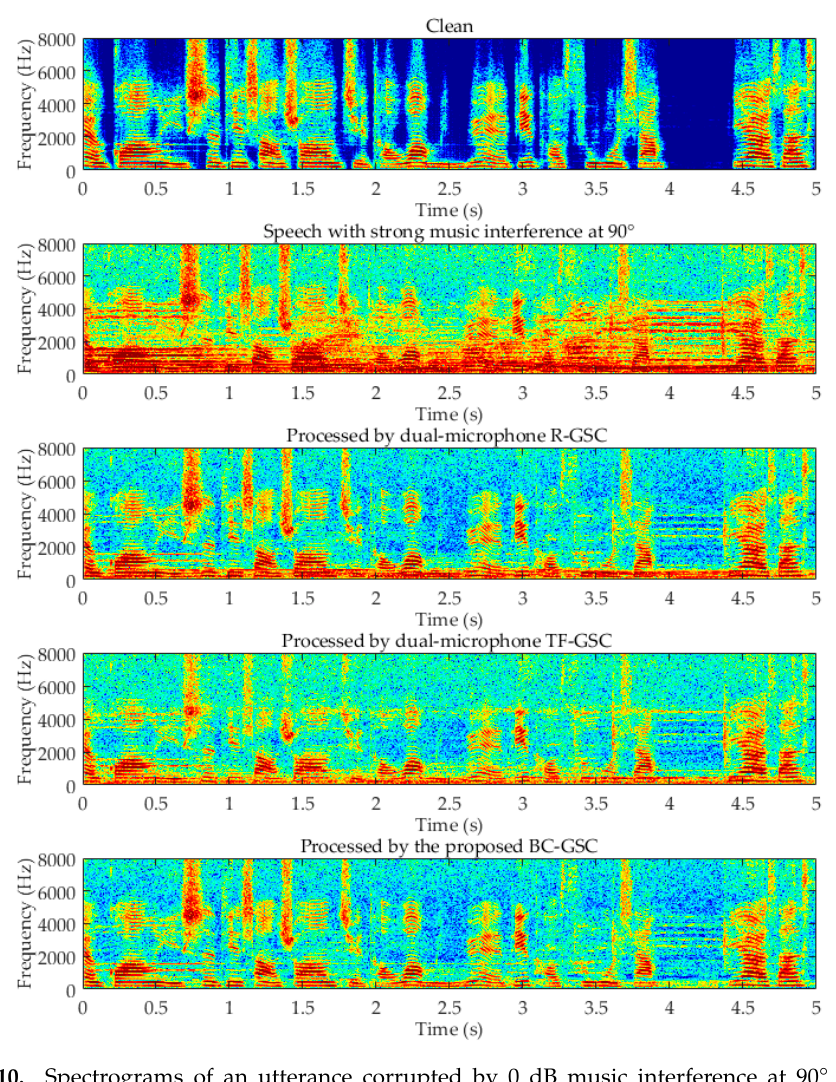
Figure 10. Spectrograms of an utterance corrupted by 0 dB music interference at 90° and the processing results by the robust (R)-GSC, the transfer-function (TF)–GSC and the proposed BC–GSC methods, respectively.